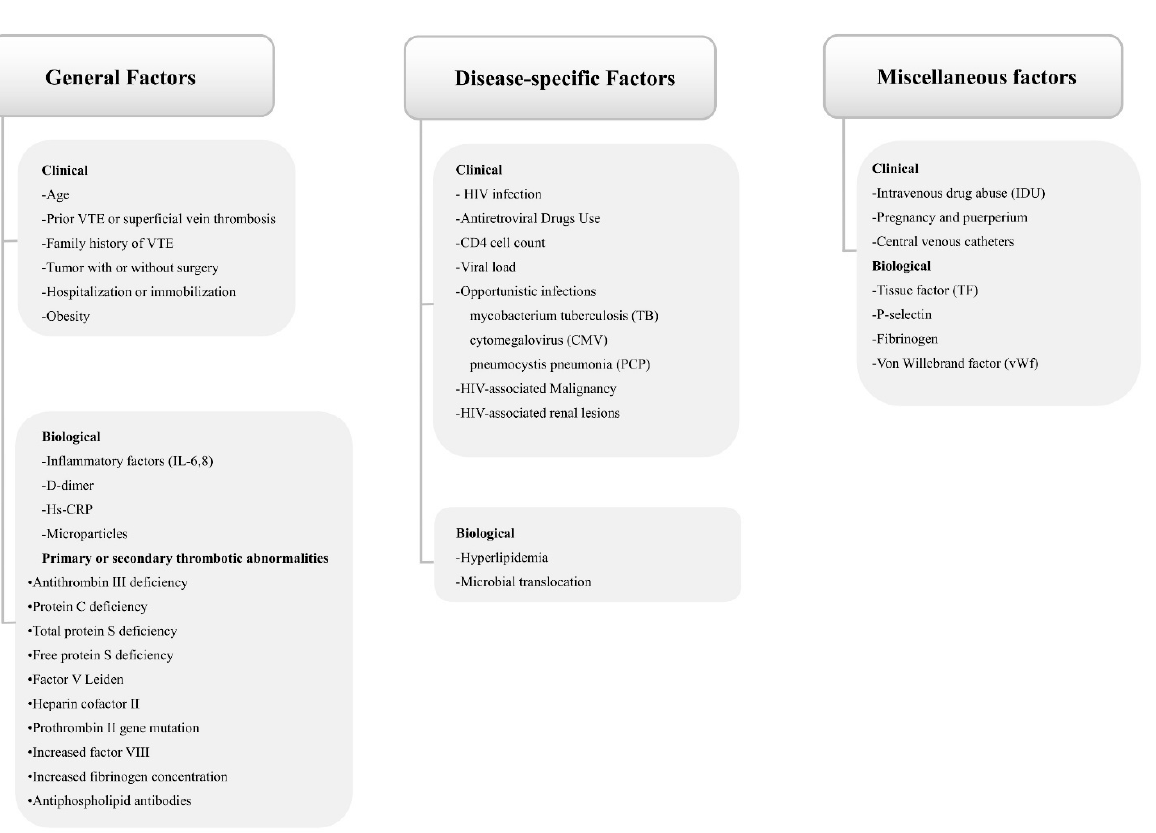
Figure 1. Various factors implicated in HIV-associated thrombosis.